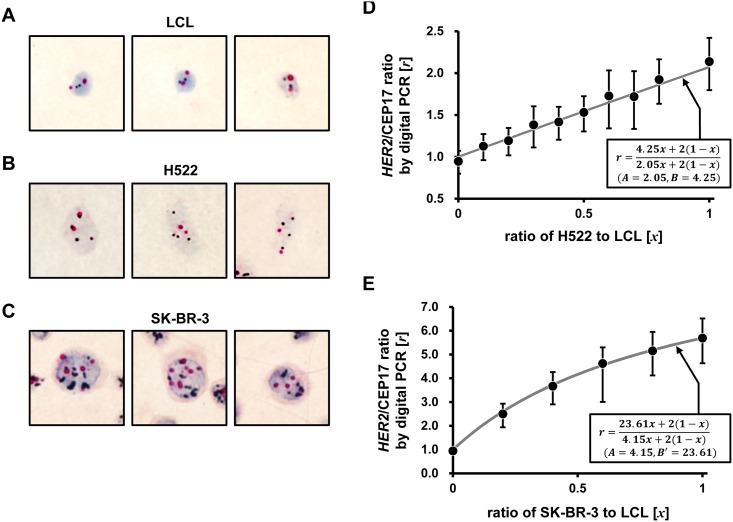
HER2-DISH in cell blocks and TC chart in the stepwise mixture system.(A–C) Micrographs of HER2-DISH of LCL, H522, and SK-BR-3 FFPE cell blocks. HER2 signals are shown as black dots or clusters, and CEP17 signals are shown as red dots. HER2 and CEP17 copy numbers measured by HER2-DISH and digital PCR are shown in Table 2. (A) The LCL was genomically stable with two pairs of signals corresponding to HER2 and CEP17, mimicking non-cancerous stromal or inflammatory cells. (B) In H522 cells, both HER2 and CEP17 signals appeared as dots and individual signals were discernible. (C) In SK-BR-3 cells, HER2 signals formed clusters and exact measurements were difficult. CEP17 signals varied between 3 and 7, with an average score of 83/20 = 4.15. (D, E) Genomic DNA of H522 and SK-BR-3 cells was mixed with the LCL genome in a stepwise manner and analyzed by digital PCR. The horizontal axis represents the ratio of H522 or SK-BR-3 to LCL, corresponding to TCR [x] in clinical cases; the vertical axis represents the ratio of HER2 to CEP17 in digital PCR [r]. [A] and [B] were determined by HER2-DISH (Table 1). (D) In H522, [A = 2.05] and [B = 4.25], yielding [r = (4.25x + 2(1 − x))/(2.05x + 2(1 − x))] (solid gray line). Plotted data were approximated by the theoretical line. (E) In SK-BR-3 cells, [A = 4.15], but HER2 copy number [B] was difficult to determine due to cluster formation. HER2 copy number [B′] was predicted [B′ = 5.69 × 4.15 = 23.61] based on digital PCR data [r] and CEP17 copy number [A]. The equation [r = (23.61x + 2(1 − x))/(4.15x + 2(1 − x))] is represented by the solid gray line. Plotted data were approximated by the theoretical line.